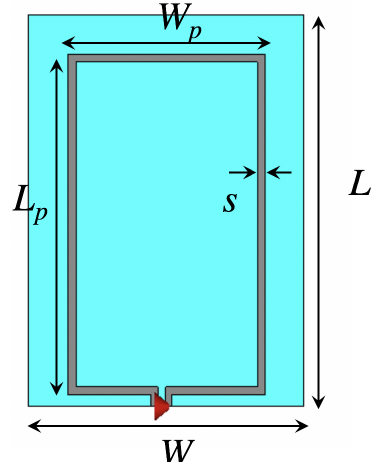
Figure 1. Top view of the modeled textile loop antenna along with its